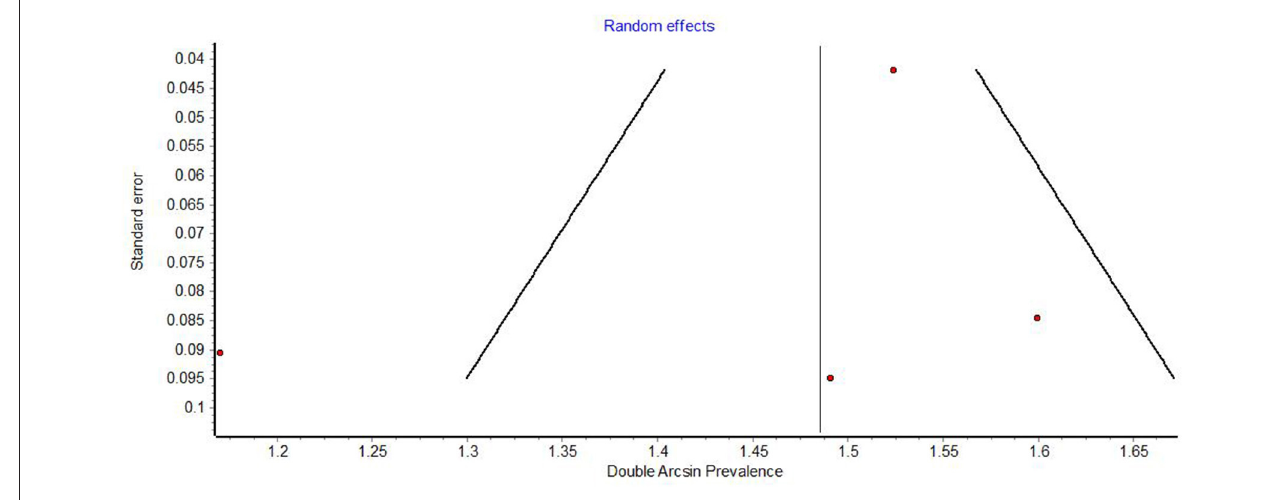
FIGURE 7 | Funnel plot of studies on the prevalence of xerostomia.